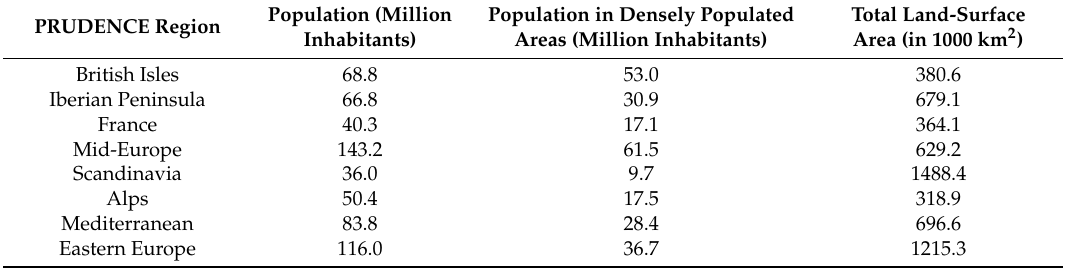
Table 3. Absolute values of population, population living in densely populated areas (areas with more than 1000 inhabitants per km 2 ) and the total land surface are shown as used within this study. Population data is take from